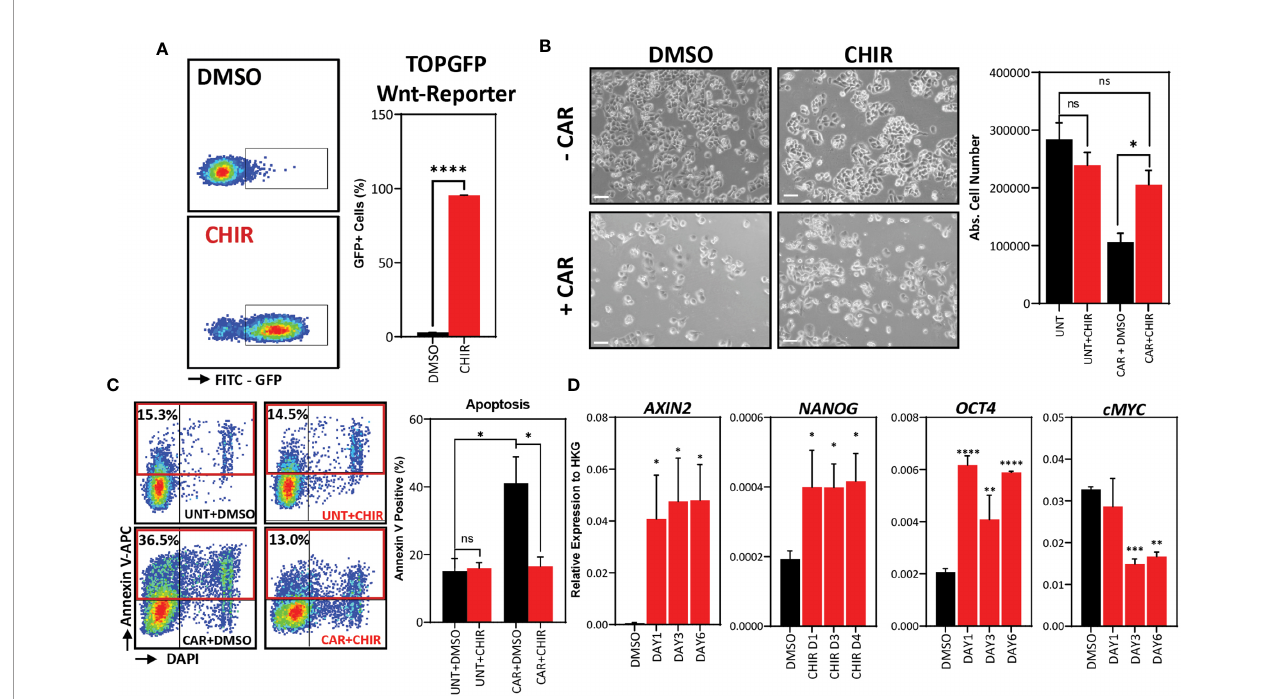
FIGURE 2 | Pharmacological in vitro Wnt induction prevents carboplatin-induced apoptosis and upregulates stem cell marker expression . (A) Representative fl ow cytometry scatterplots (left) of Wnt-reporter MDA-MB-468 TOPGFP cells treated with vehicle (DMSO) or GSK3 inhibitor (CHIR, 4 m M) for 12 hours and statistical analysis of the mean frequency of GFP+ cells using Welch ’ s t-test (right, n=3). (B) Phase-contrast microscopy images of 468 ’ P cells treated with or without carboplatin in the presence of CHIR or DMSO (left, scale bar: 100 m m) and statistical analysis of absolute cell numbers after 72 hours of each treatment using One- way ANOVA corrected for multiple comparisons using the Holm-Sidak method (n=4). (C) Representative fl ow cytometry scatterplots of annexin V staining of 468 ’ P cells (left) treated with or without carboplatin in the presence of DMSO or CHIR (4 m M) for 72 hours and statistical analysis of the mean frequency of annexin V positive cells (right) using one-way ANOVA corrected for multiple comparisons using the Holm-Sidak method (n=3). (D) Relative mRNA expression of Wnt target and stem cell markers upon 72-hour treatment with DMSO or CHIR (4 m M) in 468 ’ P cells (n=3). Multiple t-tests with Holm-Sidak correction for multiple comparisons. (Barplots represent mean + SEM. * p < 0.05; **p < 0.01; ***p < 0.001; ****p < 0.0001 ; ns, non signi fi